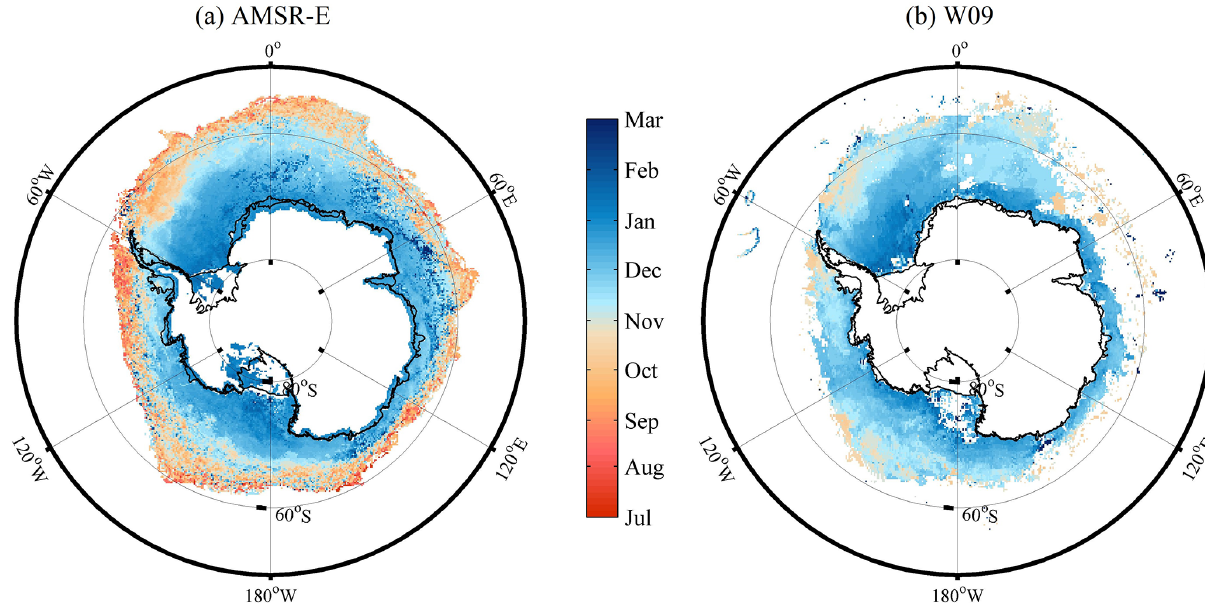
Figure 9. Annual mean CMO derived from (a) AMSR-E and (b) W09 from 2002 to 2008.